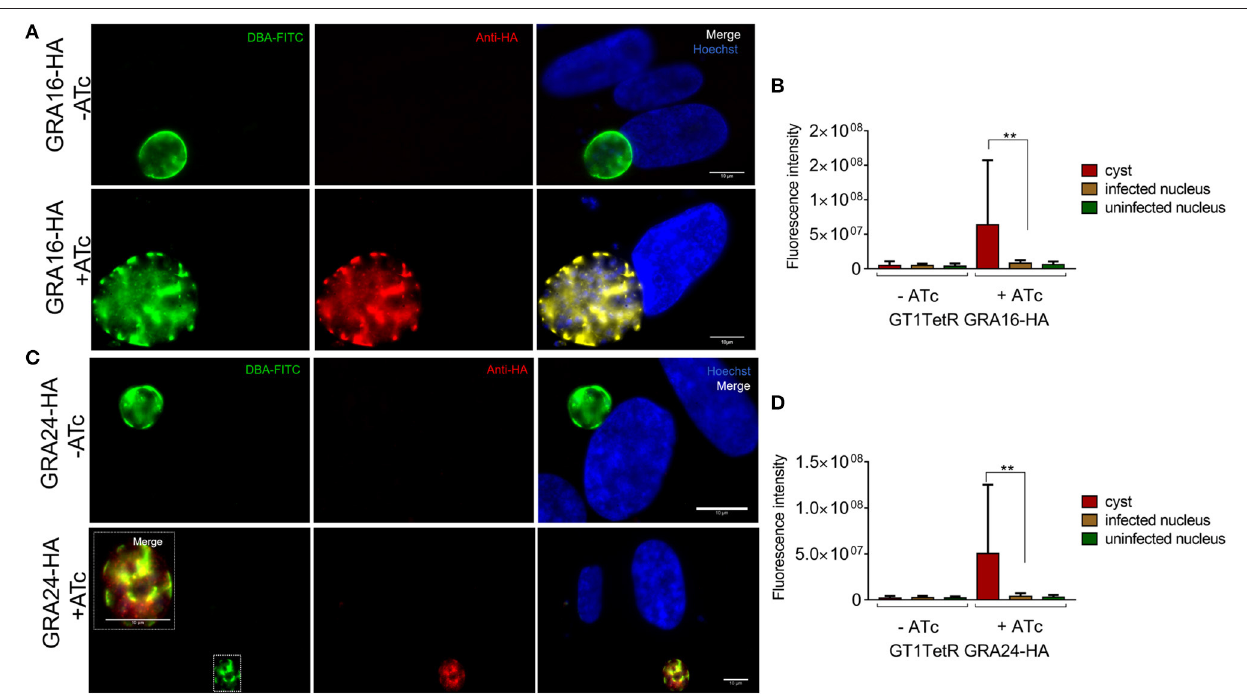
FIGURE 2 | In vitro DBA positive cysts do not secrete GRA16-HA and GRA24-HA beyond the cyst wall membrane. Stage differentiation was induced using single clones of parasites, which contained either GRA16-HA or GRA24-HA cloned in front of a TetOn promoter, 16h post infection of coverslips containing HFFs. ATc was added to the monolayer containing cysts 5 days after inducing stage differentiation. Coverslips were processed for IFA with DBA-FITC to stain the cyst wall and anti-HA antibody to track the localization of GRAs16 and 24. In the absence of ATc, GRA16-HA ( A first panel) and GRA24-HA ( A first panel) were not detected in parasites. GRA16-HA ( A second panel) and GRA24-HA ( B second panel, inset) accumulated beneath the cyst wall only in the presence of ATc. Images are scaled to 10 µ m. Fluorescence intensity was measured to quantify the localization of GRA16-HA and GRA24-HA in the nucleus of infected cells, uninfected cells as well as the tissue cysts in the presence and absence of ATc (C,D) . Signal intensity was the highest and above background (uninfected cells) only for cysts in the presence of ATc. Error bars indicate mean with SD and significance was determined using Student’s t -test from 3 biological replicates (** P <